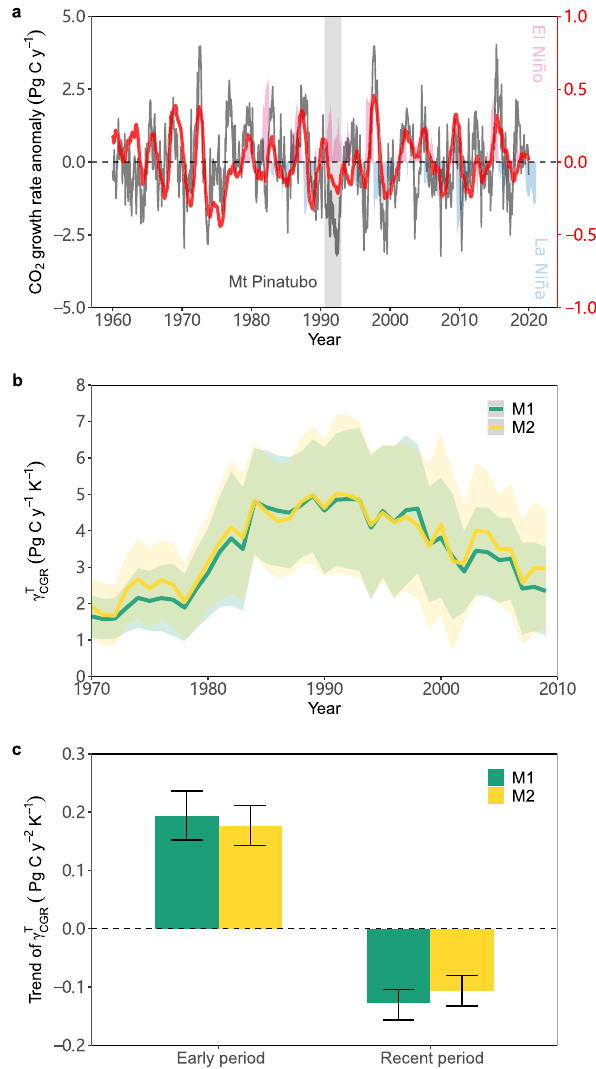
Fig. 1 | Change in detrended anomalies in CO 2 growth rate and tropical tem- perature. a Changes in anomalies of detrended CO 2 growth rate (CGR) at the Mauna Loa Observatory (black) and in anomalies of detrended tropical tempera- ture (red) derived from the CRU dataset for 1960 – 2020. Tropical temperature is calculated from the spatial average over vegetated tropical land, 24° N to 24° S. b Change in γ T CGR for the last six decades. γ T CGR is calculated using two multiple regression approaches referring to Eqs. 1 – 2 (M1 and M2, see “ Methods ” ) with the annualCGRandclimaticvariablesinamovingwindowof20years.CGRintheyears of 1992 – 1993 are excluded due to the eruption of Mt Pinatubo. The shaded areas denote1SDofthesensitivityderivedfroma20-ymovingwindowin500bootstrap estimates. The years on the x-axis indicate the central year of the moving window used to derive γ T CGR . c Trends in γ T CGR from 1960 – 1979 to 1979 – 2000 (early period) and 1980 – 2001 to 2001 – 2020 (recent period). Signi fi cance ( P <0.05) is identi fi ed using the Mann-Kendall trend test for both periods. The error bars represent the 95% con fi dence